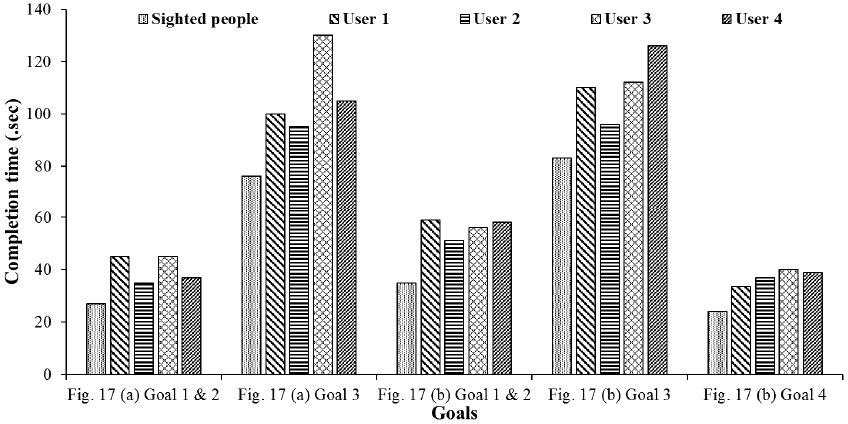
Figure 19. Time taken by each user to accomplish the goals (sec.).